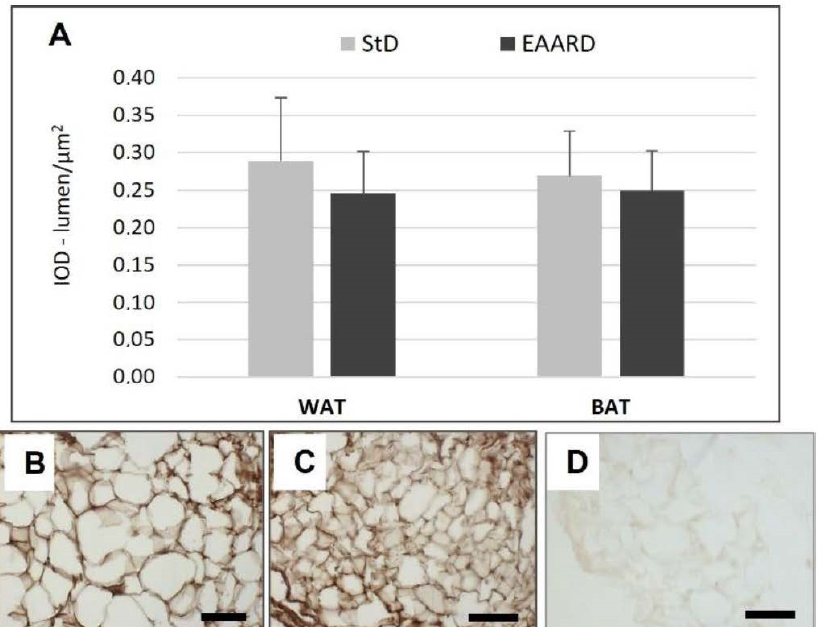
Figure 7. ( A ): Optical density for FAS immunostaining in rpWAT ( t = 1.651, p = 0.869) and BAT ( t = 0.081, p = 0.93) according to diet (mean ± sd). ( B , C ): Representative images of rpWAT IHC in StD and EAARD-fed mice, respectively. ( D ): Negative control performed by omitting the primary antibody. Original magnification 20 × ; scale bar 50 µ m.